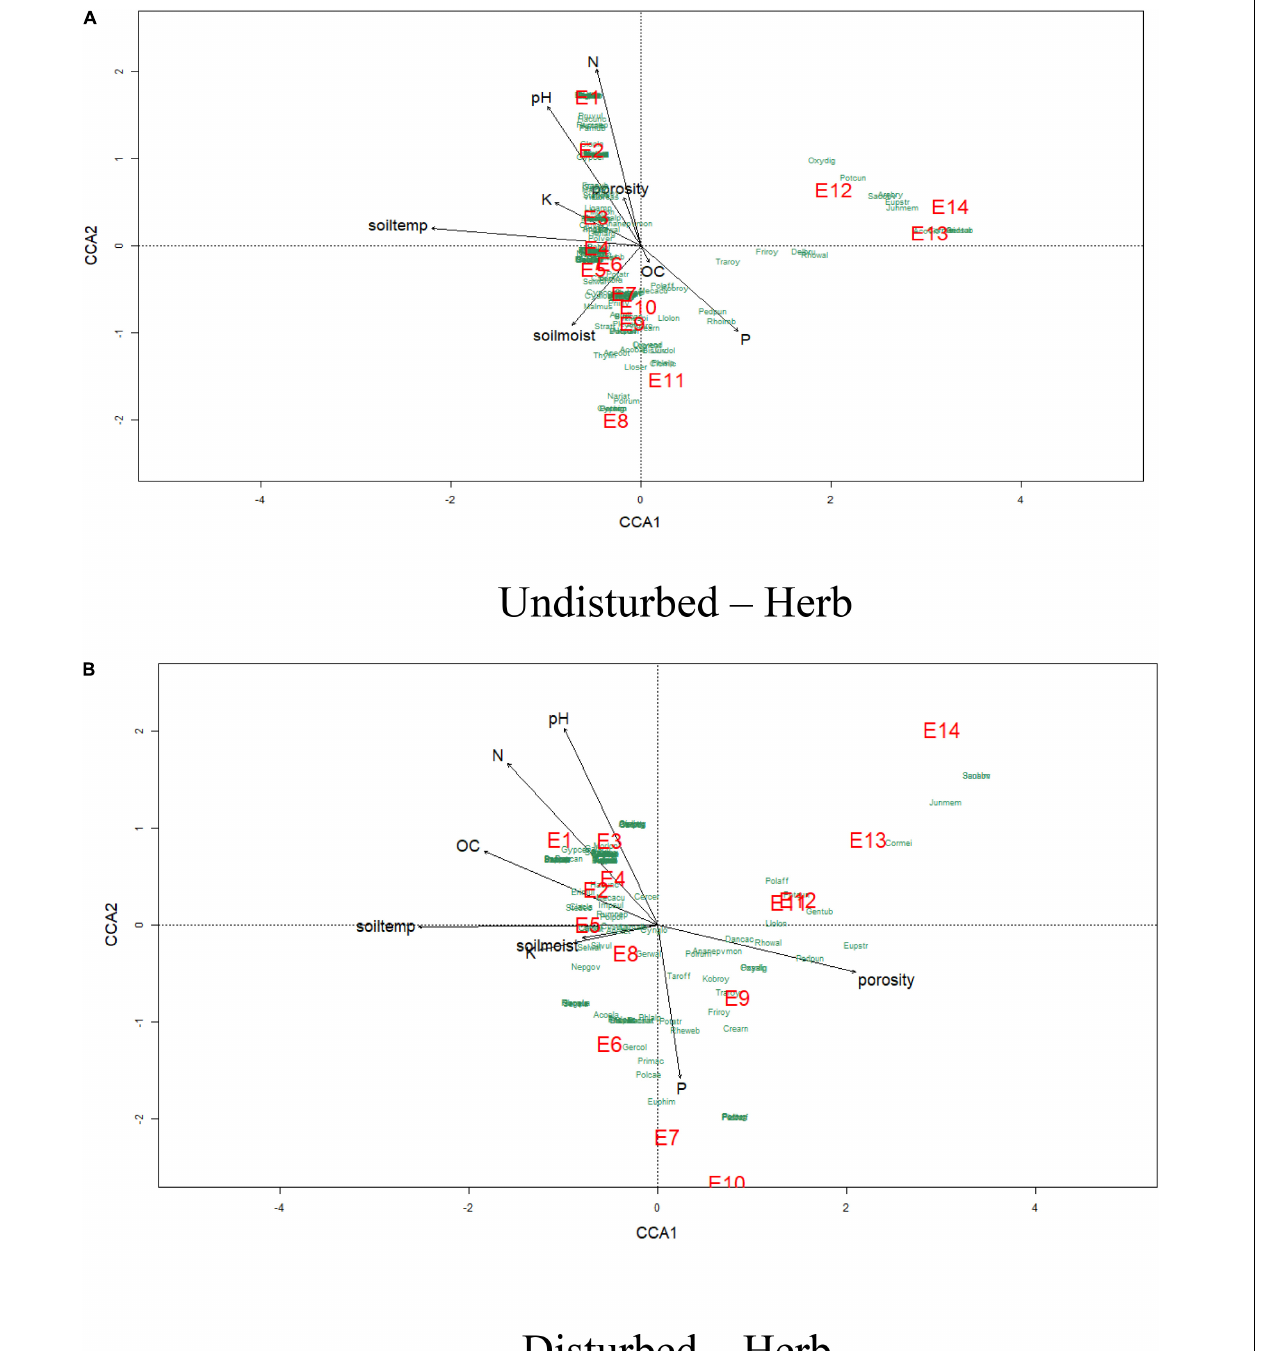
activities viz . trampling, unsustainable harvesting for research- oriented work, etc. are the major causes of habitat depletion in protected sites of VoFNP. Dense colonies of weedy